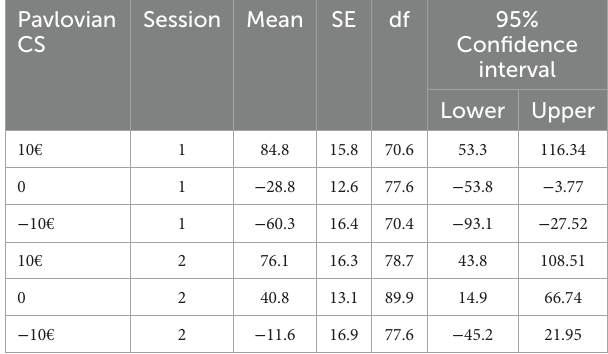
TABLE 4 Estimated marginal means.